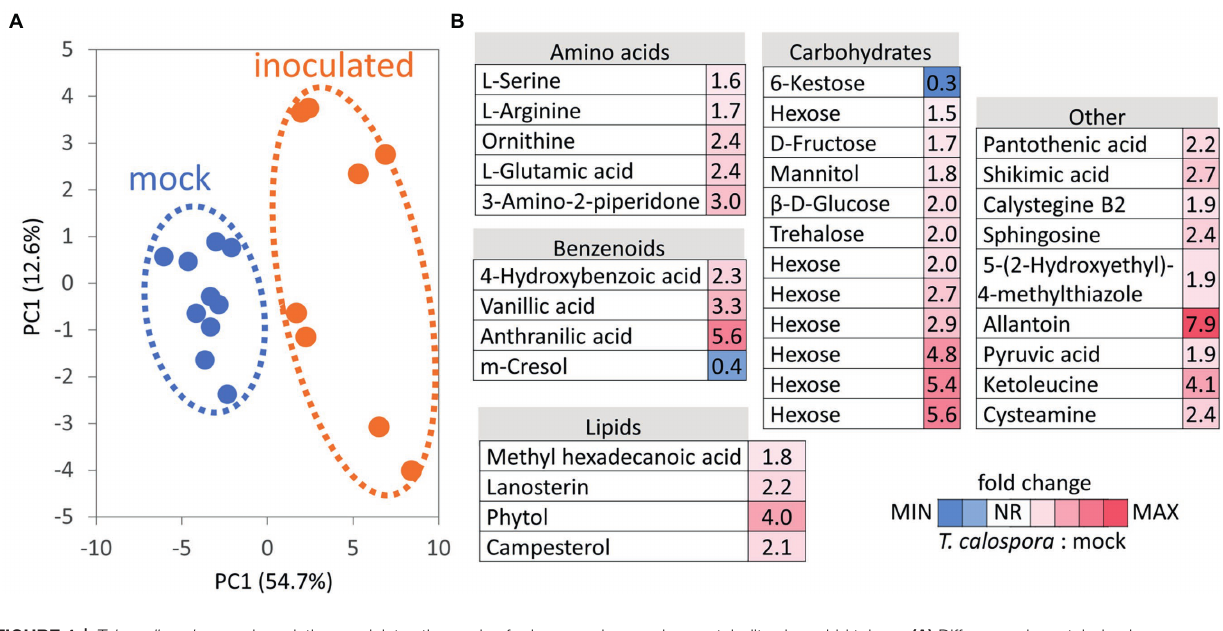
FIGURE 4 | Tulasnella calospora inoculation modulates the pools of primary and secondary metabolites in orchid tubers. (A) Differences in metabolomic composition visualized by Principal Component Analysis. (B) Heat map visualization of detected differentially abundant metabolites. Results of at least four biological replicates (tubers of four inoculated plants and five mock-treated controls) analyzed in two technical replicates. For details, see Supplementary Table S3